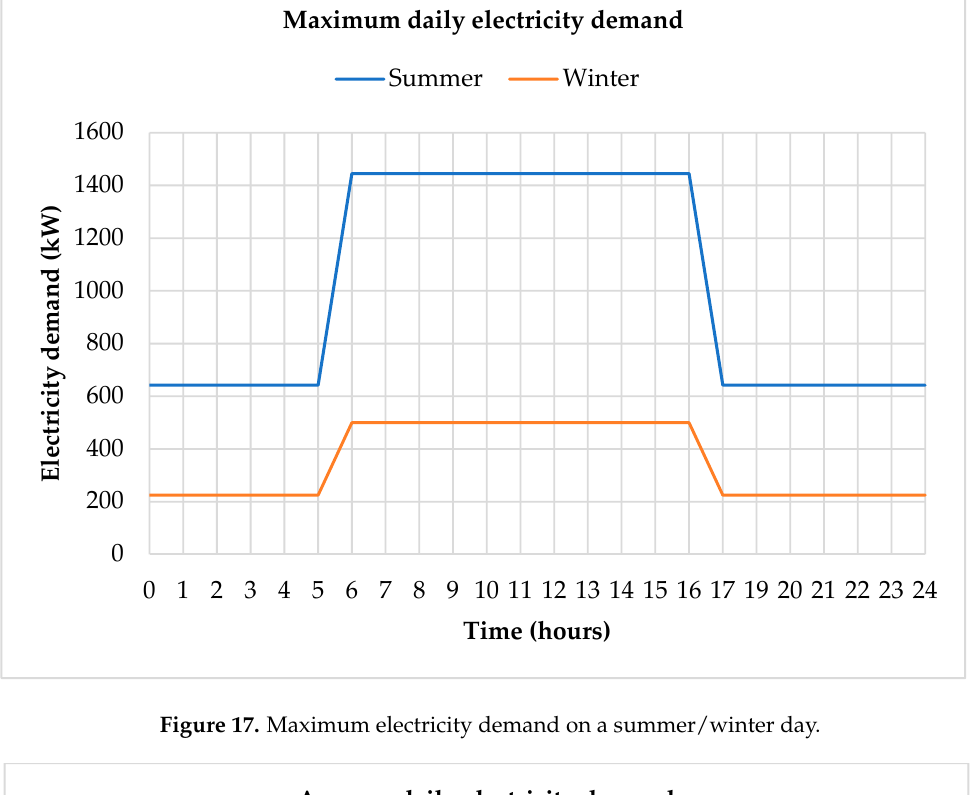
Figure 17. Maximum electricity demand on a summer/winter day.